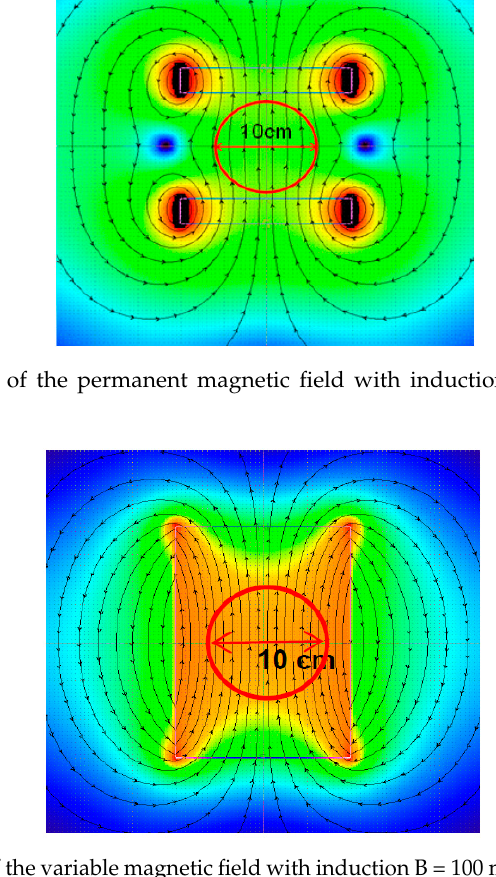
Figure 2. Distribution of the variable magnetic field with induction B = 100 mT and frequency f = 50 Hz, within the sample extract.